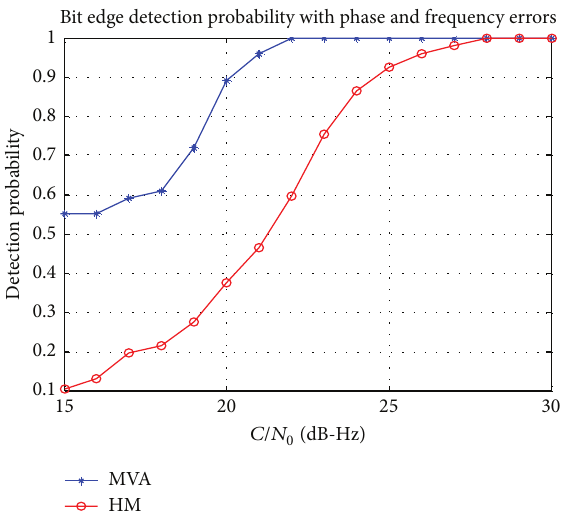
Figure 5: With phase and frequency